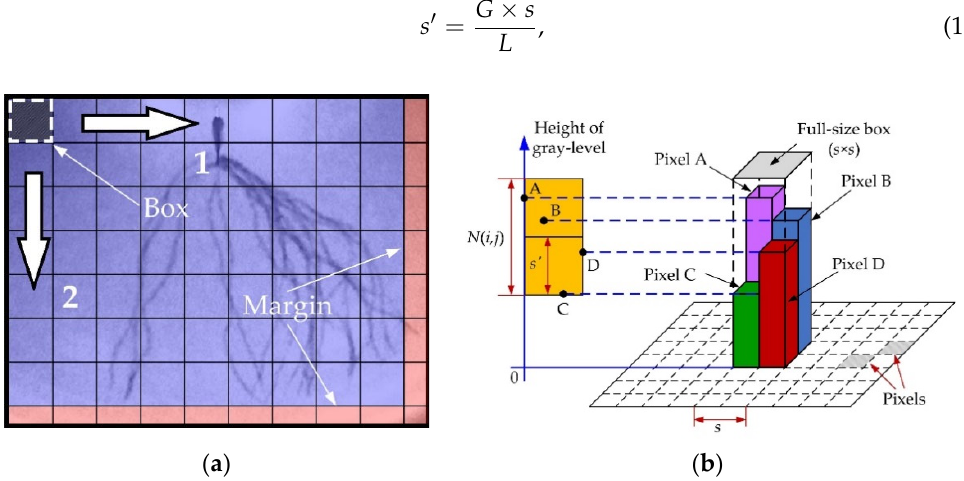
Figure 5. Illustration of differential box ‐ counting method for tracking by full ‐ size box. ( a ) illustrates the covering procedure from upper left to lower right. ( b ) shows the counting procedure of differential height for a certain block covered by full ‐ size box.